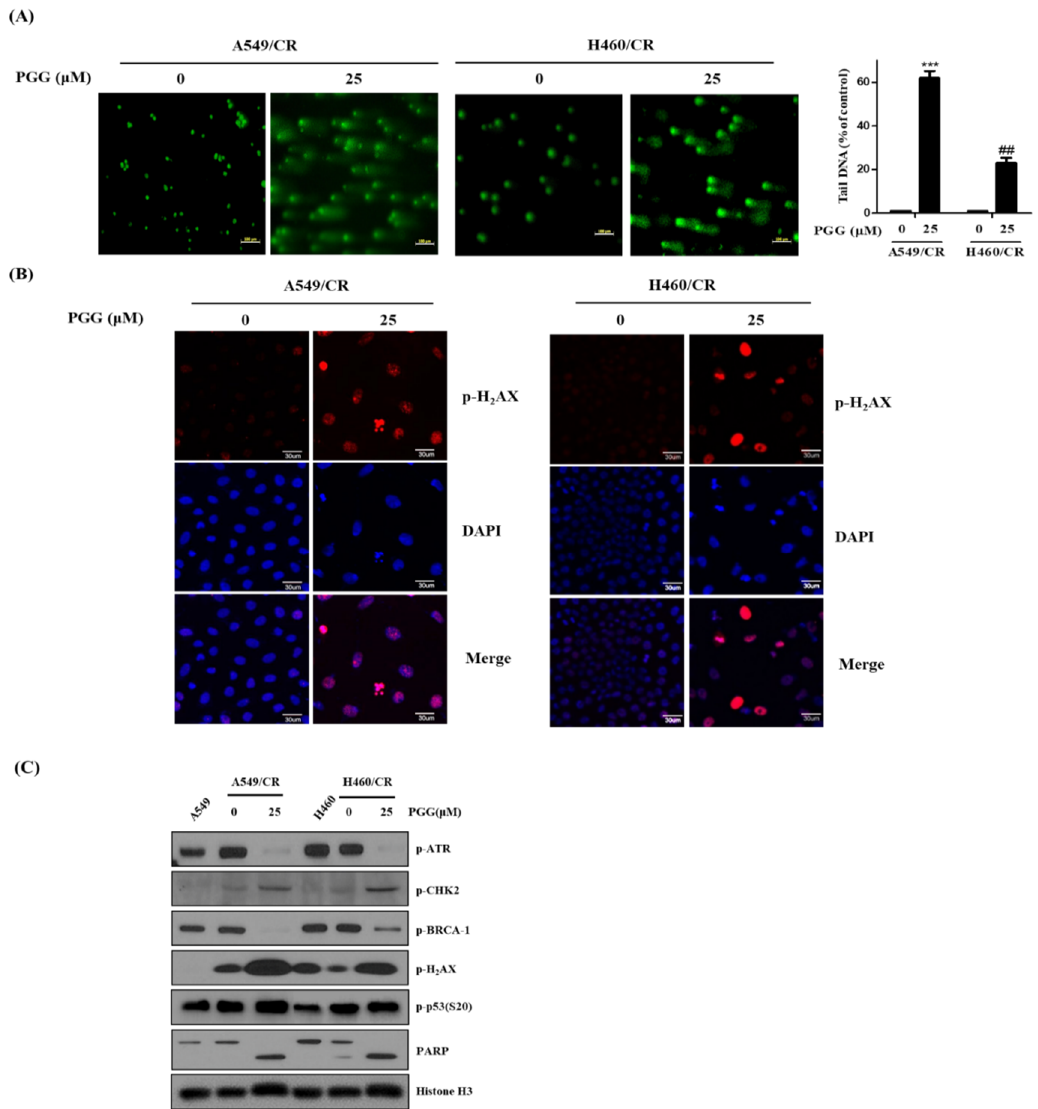
Figure 4. Effect of PGG on DNA damage proteins in A549/CR and H460/CR cells. ( A ) Effect of PGG on the comet tails in A549/CR and H460/CR cells by Comet assay. ***, p < 0.001 vs. untreated control, ##, p < 0.01 vs. untreated control. ( B ) Effects of PGG on pH 2 AX in A549/CR and H460/CR cells by immunofluorescence ( × 60). ( C ) Effects of PGG on DNA damage proteins in A549/CR and H460/CR cells. Three independent assays were